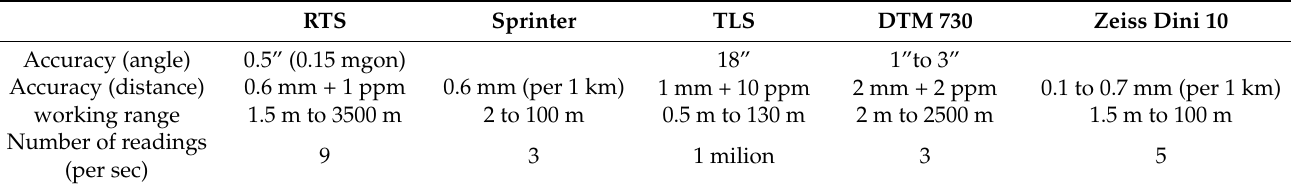
Table 2. The technical data of the available